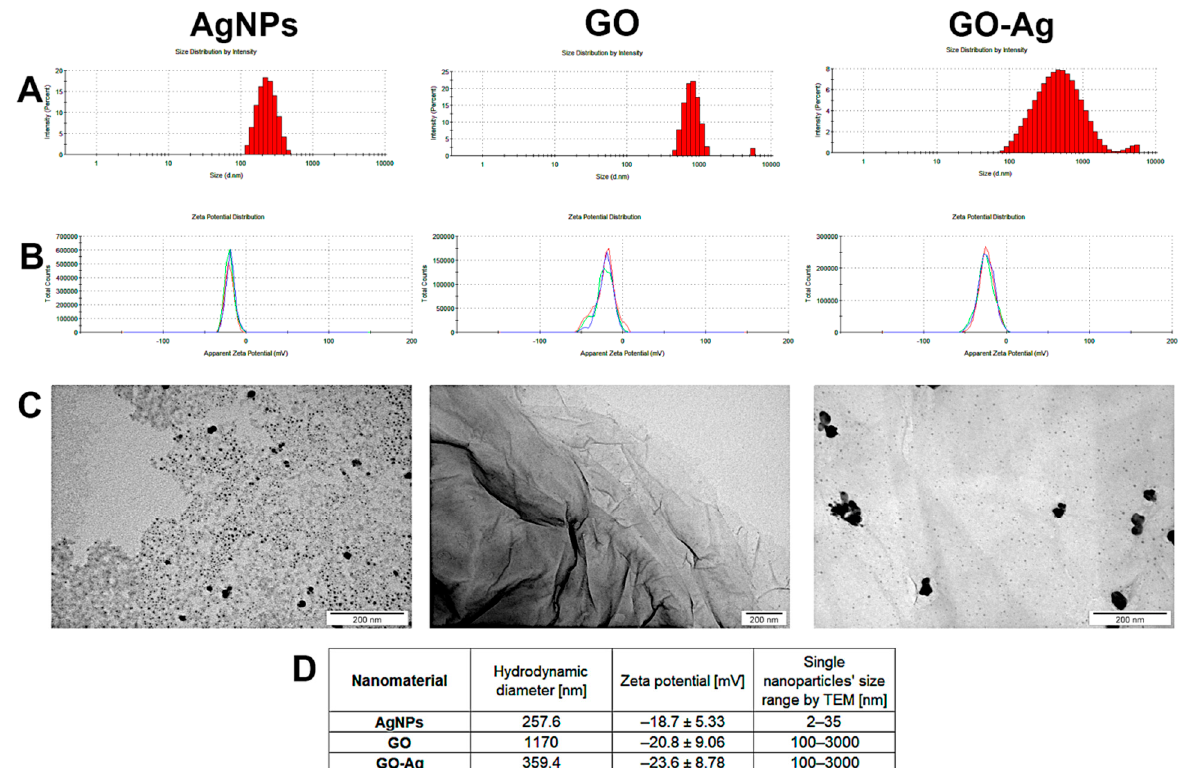
Figure 1. Physicochemical characterization of nanomaterials-silver (AgNPs), graphene oxide (GO) and GO with AgNP complexes (GO-Ag): ( A ) hydrodynamic diameter measured by dynamic light scattering; ( B ) zeta potential of nanomaterials measured by laser Doppler electrophoresis, three colors (blue, green, red) represent repeated measurements of the same sample; ( C ) TEM visualization; ( D ) values of measurements. Each measurement was repeated three times.